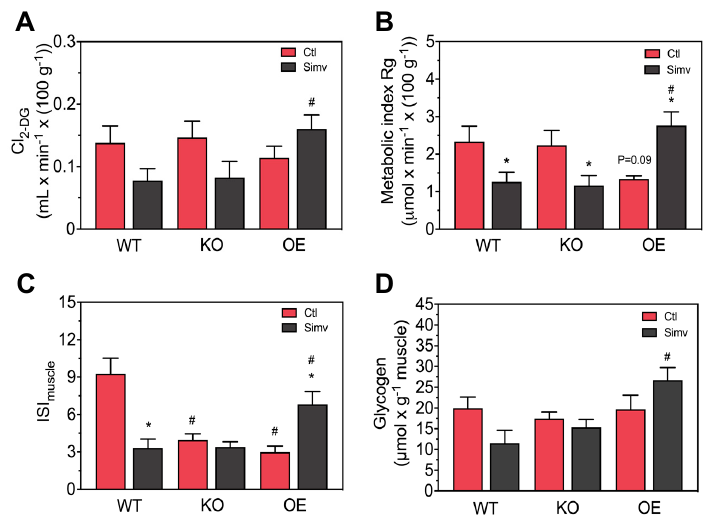
Figure 4. Glucose uptake and muscle glycogen. Muscle specific glucose uptake is shown as clearance for 2-deoxyglucose (2-DG) Cl 2-DG ( A ) and as the metabolic index (Rg), which reflects skeletal muscle glucose uptake ( B ). The ratio of muscle glucose uptake and the average insulin blood concentration was calculated as a muscle-specific marker of insulin sensitivity (ISI muscle ) ( C ). Glycogen content was measured from gastrocnemius muscle ( D ). After two-way ANOVA analysis, we found significant treatment effects in ( B , C ), significant animal model effects in ( A – D ) and the interaction between treatment and animal model was significant in ( A – C ). Data are presented as mean ± SEM of 4–8 animals per group. * p < 0.05 between simvastatin-treated and respective control mice and # p < 0.05 between KO or OE and WT mice within the same treatment group. Ctl, control; KO, PGC-1 α knock-out mice; OE, PGC-1 α overexpressing mice; Simv, simvastatin; WT, wild-type.